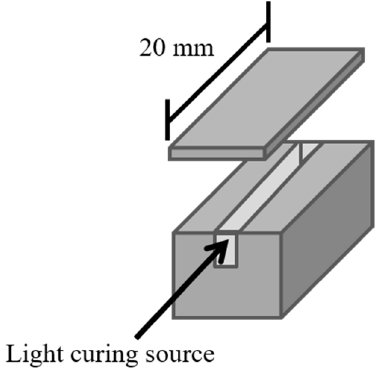
Figure 3. The test method for curing depths according to ISO 4049:2009 [33] .